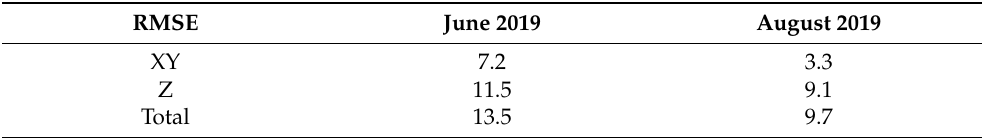
Table 5. RMSE values (in cm) computed from the positional errors obtained for ICPs.